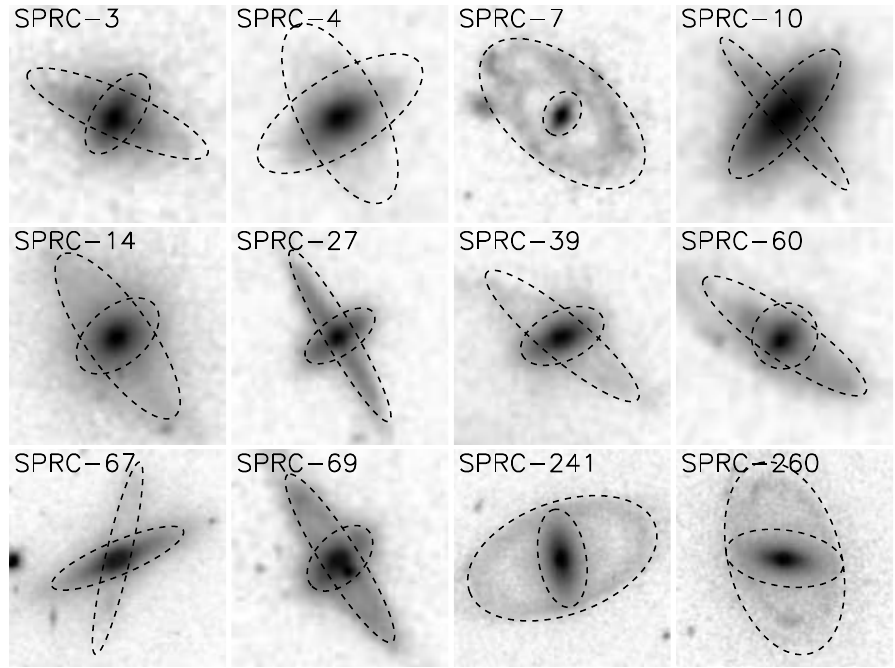
Fig. 1. SDSS DR9 images ( g + r + i ) of the SPRC galaxies with polar structures con(cid:12)rmed by kinematical measurements with the Russian 6 m telescope (see references in Moiseev et al. 2014). The ellipses mark the adopted outer borders of the central galaxy disk and polar ring according to Smirnova & Moiseev